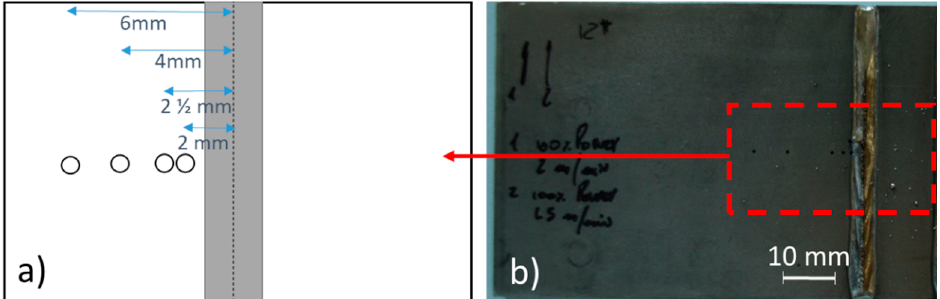
Figure 2 . ( a ) Schematic view of thermocouple holes and ( b ) photograph of the holes in relation to the weld.